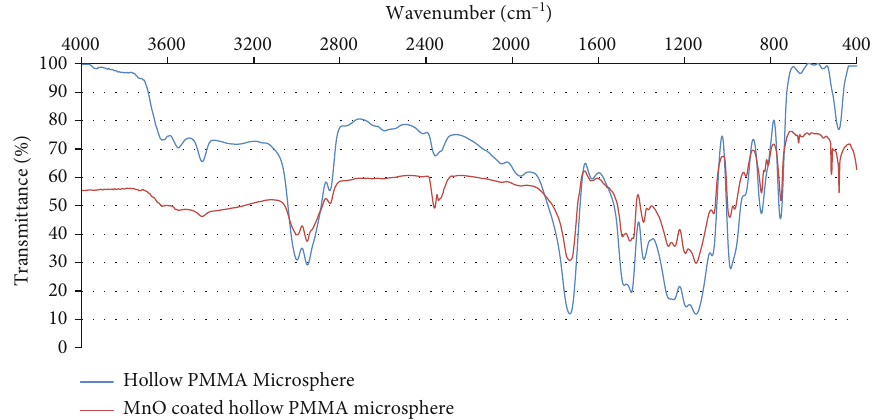
Figure 6: FTIR analysis of HPM and MHPM.